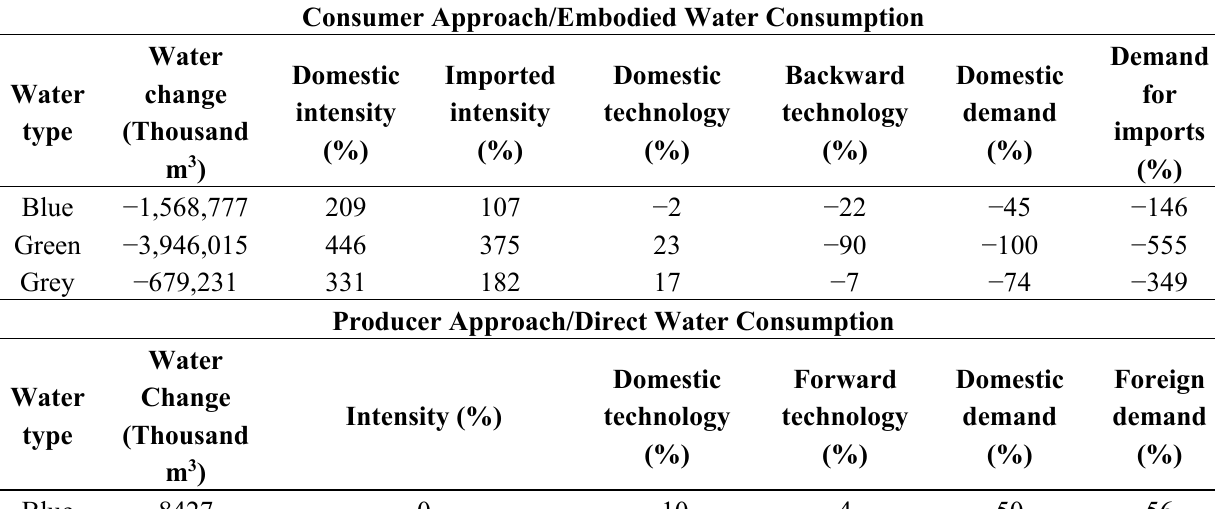
Table 4. Decomposition analysis of water